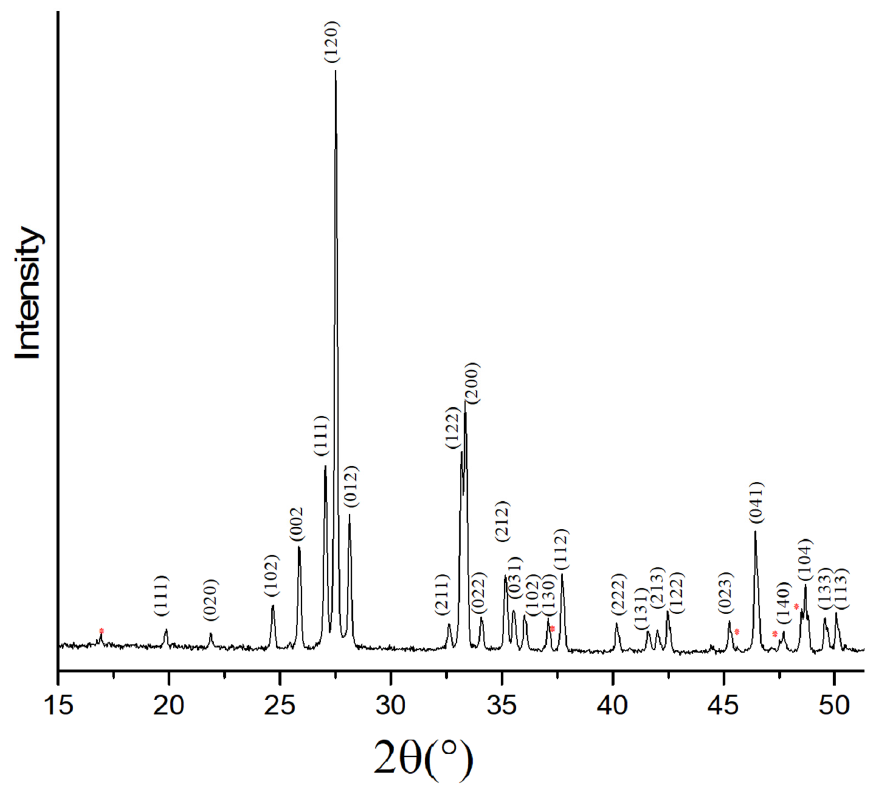
Figure 1. XRD pattern of the synthesized Bi 2 O 3 . Reflection of bismuth oxide is tagged according to Miller indices. Red * represents the reflection not related to bismuth oxide.